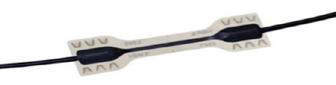
Figure 1. Weldable deformation sensor. Figure 2. Temperature sensor.